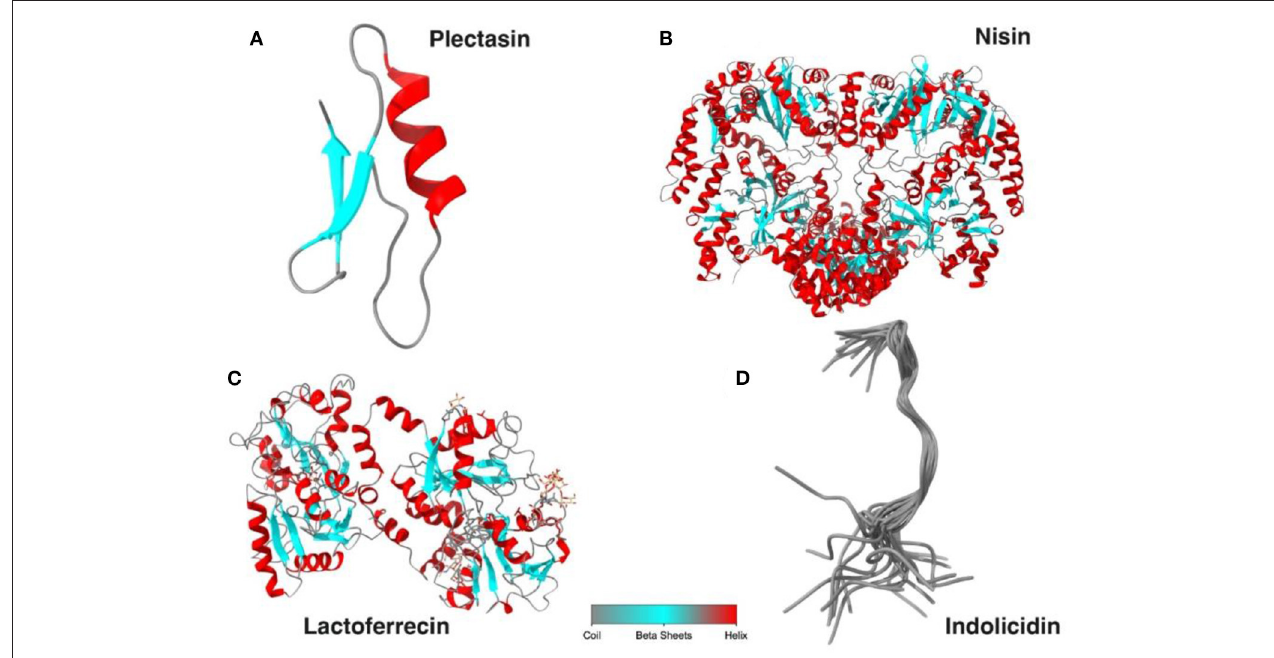
FIGURE 5 | The diagram illustrates the peptide structure for plectasin (A) , nisin (B) , lactoferricin (C) , and indolicin (D) . The image was created using UCSF Chimera